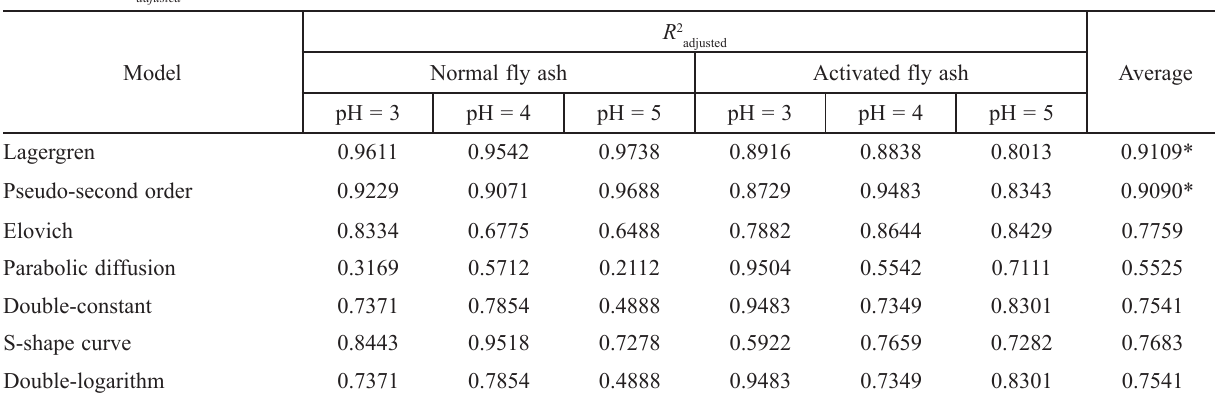
Table 3 – R 2 criterion for the sorption of Zn on coal fly ash materials adjusted